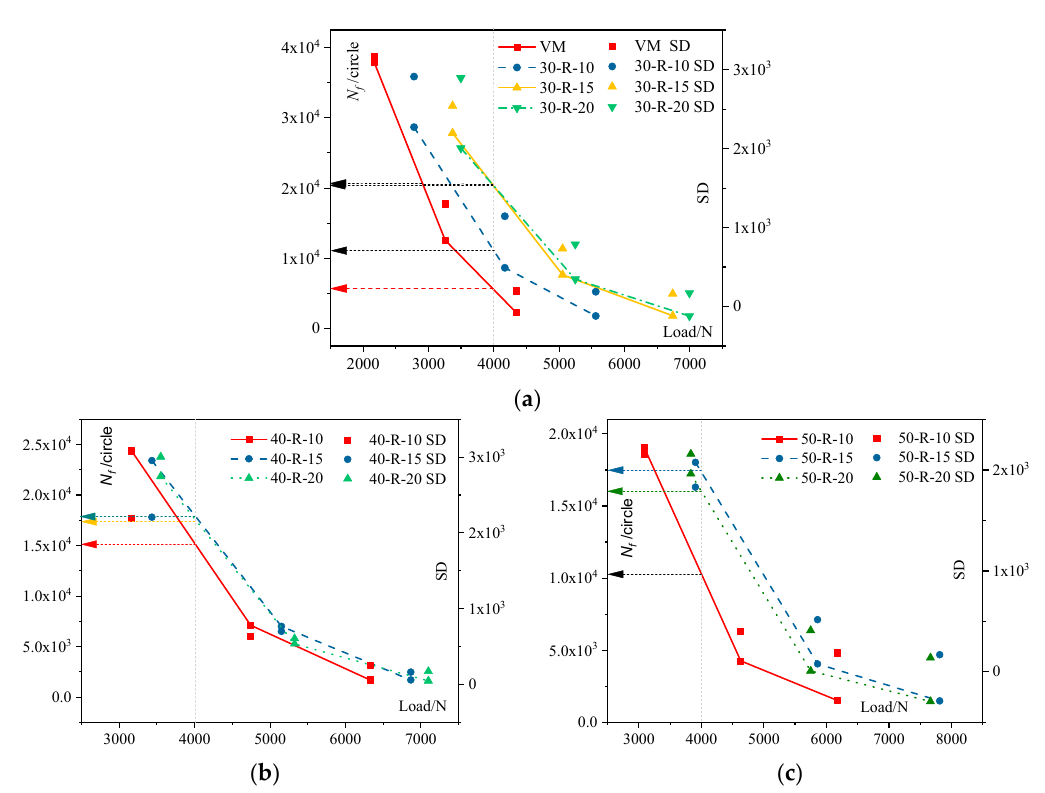
Figure 6. The load and fatigue life between ( a ) the virgin asphalt mixture and recycled mixture with 30% reclaimed asphalt pavement (RAP), ( b ) recycled mixture with 40% RAP, and ( c ) recycled mixture with 50% RAP.